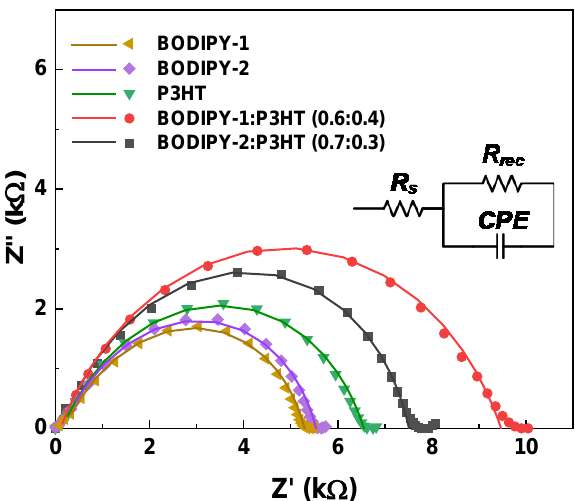
Figure 5. The electrochemical impedance spectroscopy (EIS) spectra of BODIPY-1 , BODIPY-2 , and P3HT binary solar cells and BODIPY-1 :P3HT (0.6:0.4) and BODIPY-2 :P3HT (0.7:0.3) ternary solar cells under 1 sun simulation and an open circuit condition.